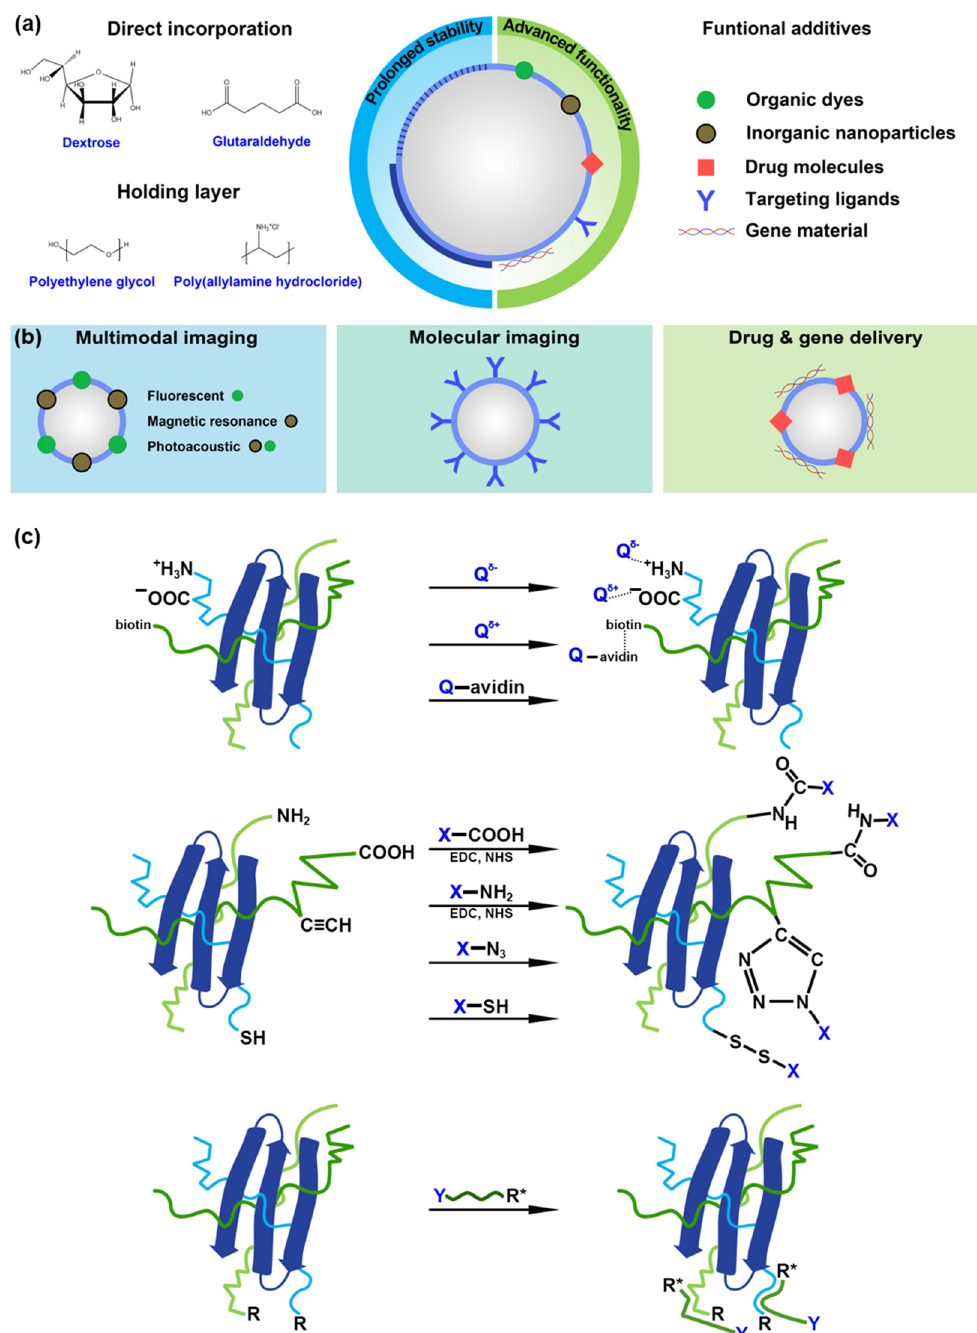
Figure 4. Chemical routes for stabilization and functionalization of MBs with protein shell. ( a ) Pro-